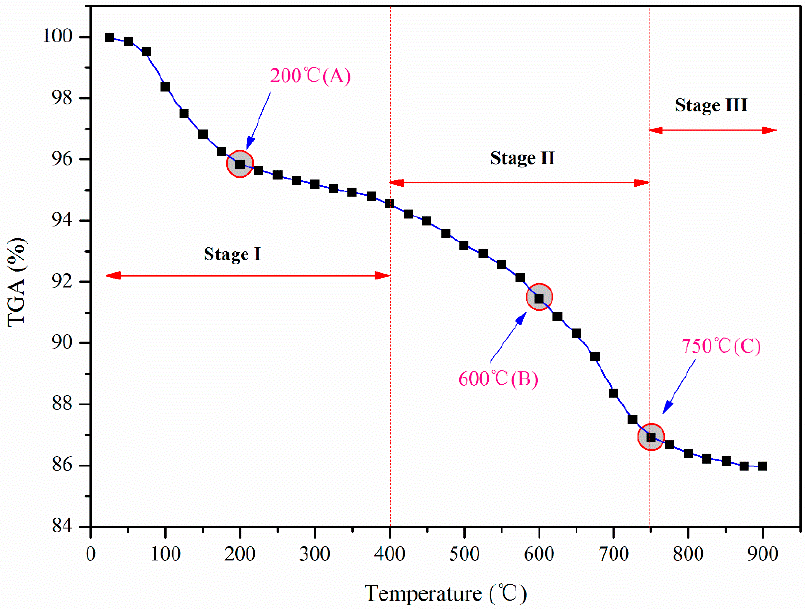
Figure 6. TGA curve changes of sandstone during heating treatment.